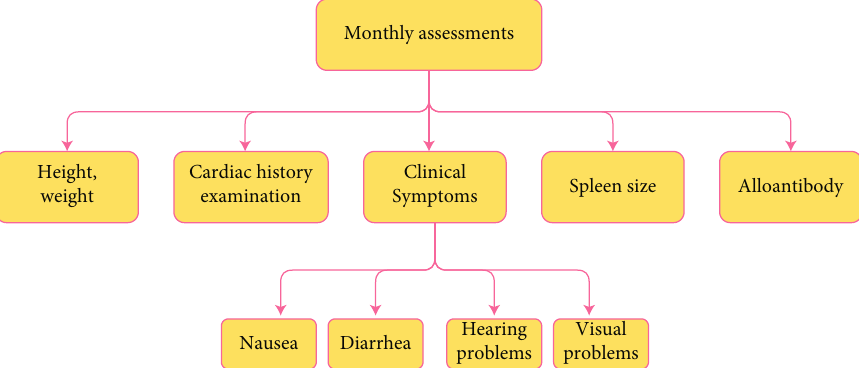
Figure 3: Semantic network representation of the monthly follow-up